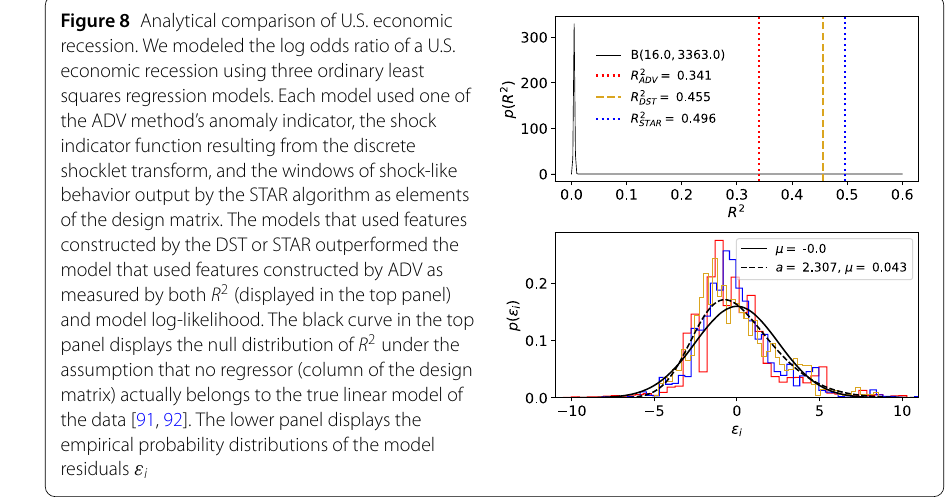
Figure 8 Analytical comparison of U.S. economic recession. We modeled the log odds ratio of a U.S. economic recession using three ordinary least squares regression models. Each model used one of the ADV method’s anomaly indicator, the shock indicator function resulting from the discrete shocklet transform, and the windows of shock-like behavior output by the STAR algorithm as elements of the design matrix. The models that used features constructed by the DST or STAR outperformed the model that used features constructed by ADV as measured by both R 2 (displayed in the top panel) and model log-likelihood. The black curve in the top panel displays the null distribution of R 2 under the assumption that no regressor (column of the design matrix) actually belongs to the true linear model of the data [91, 92]. The lower panel displays the empirical probability distributions of the model residuals ε